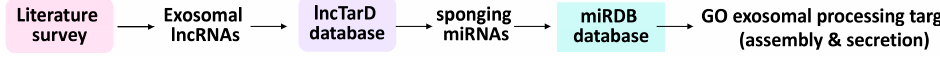
Figure 2. Steps in fi lling the knowledge gap between exosomal lncRNA and sponging miRNAs and between miRNAs and exosomal processing targets, as provided by lncTarD [34] and miRDB [38]